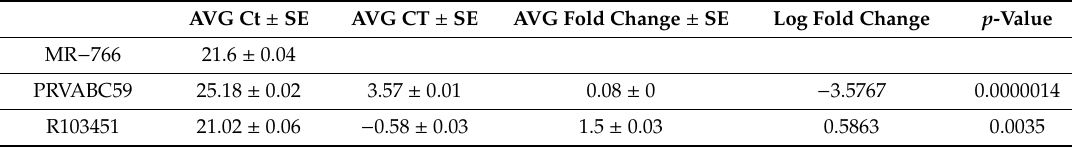
Table 1. Di ff erential RT-PCR detection of three Zika virus (ZIKV) strains. Three ZIKV strains detected with CDC ZIKV general primers and probe. MR − 766 was used as the reference when calculating Ct, fold change, and p